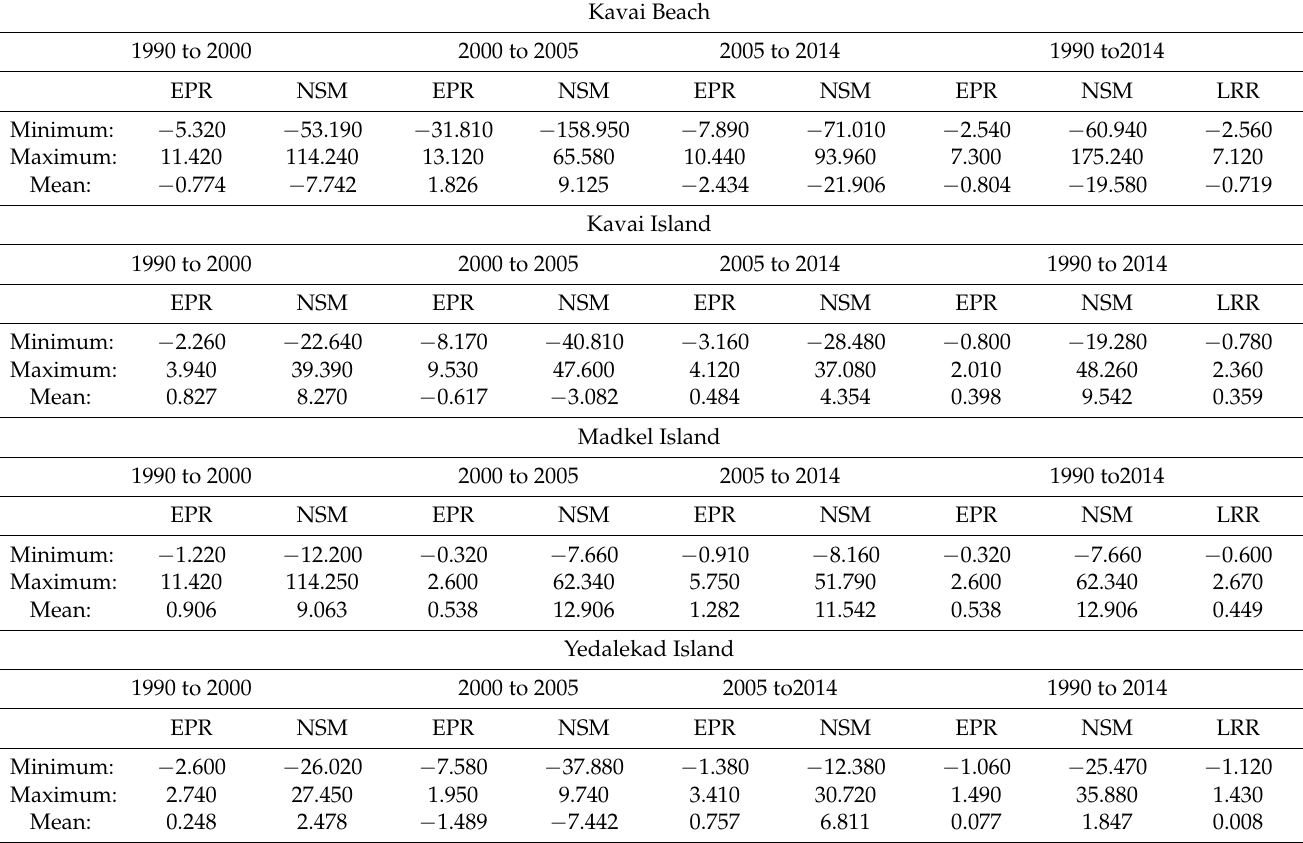
Table 1. Representation of Digital Shoreline Analysis System of Kavvayi wetland. Kavai